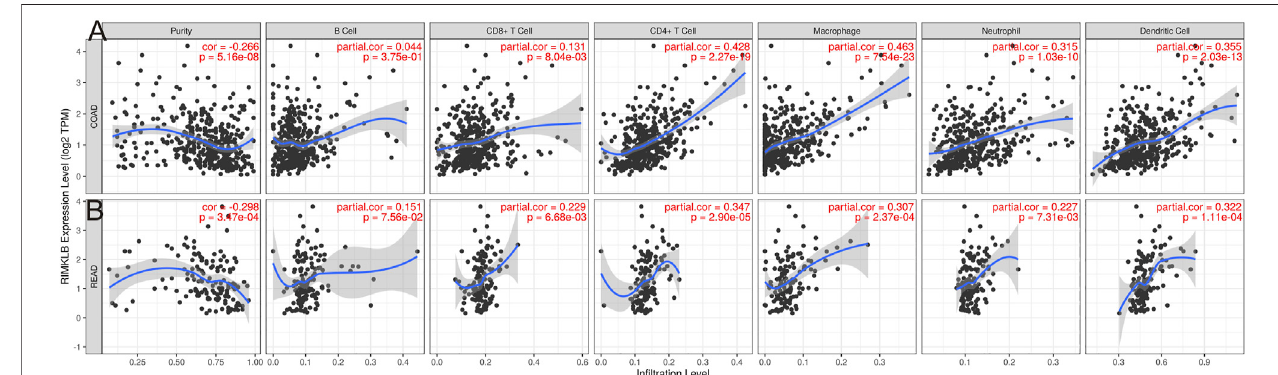
FIGURE 5 | Correlation of RIMKLB expression with immune in fi ltration level in COAD (colon adenocarcinoma), and READ (recutm adenocarcinoma) in the TIMER database. (A) RIMKLB expression is signi fi cantly negatively related to tumor purity and has signi fi cant positive correlations with in fi ltrating levels of CD8 + T cells, CD4 + T cells, macrophages, neutrophils, and dendritic cells in COAD, other than B cells. (B) RIMKLB expression is signi fi cantly negatively related to tumor purity and has signi fi cant positive correlations with in fi ltrating levels of B cells, CD8 + T cells, CD4 + T cells, macrophages, neutrophils, and dendritic cells in READ.